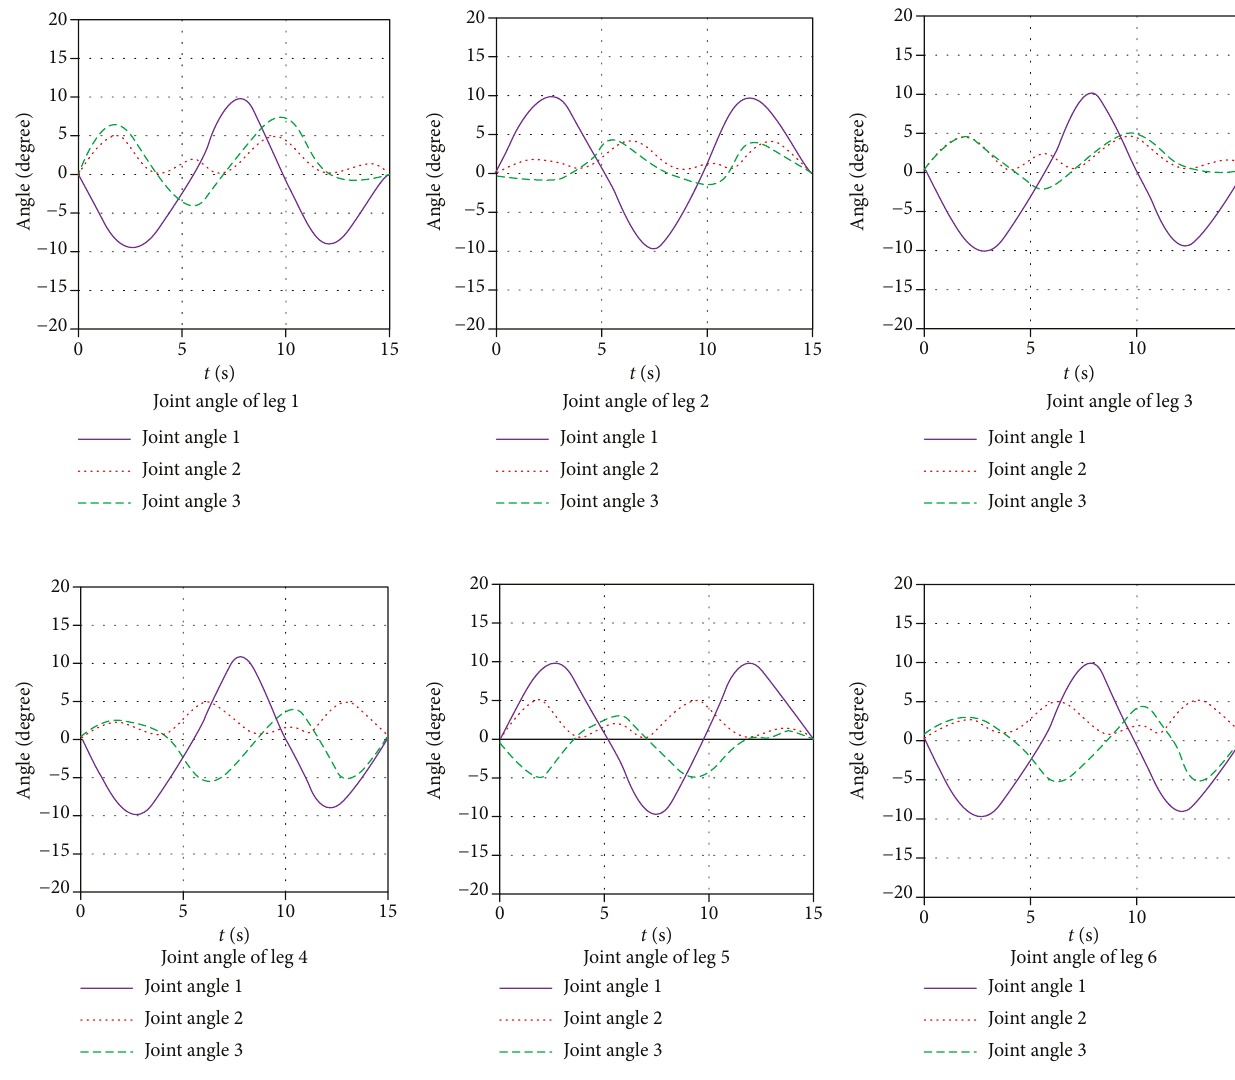
Figure 15: The joint angle change with time in triangular